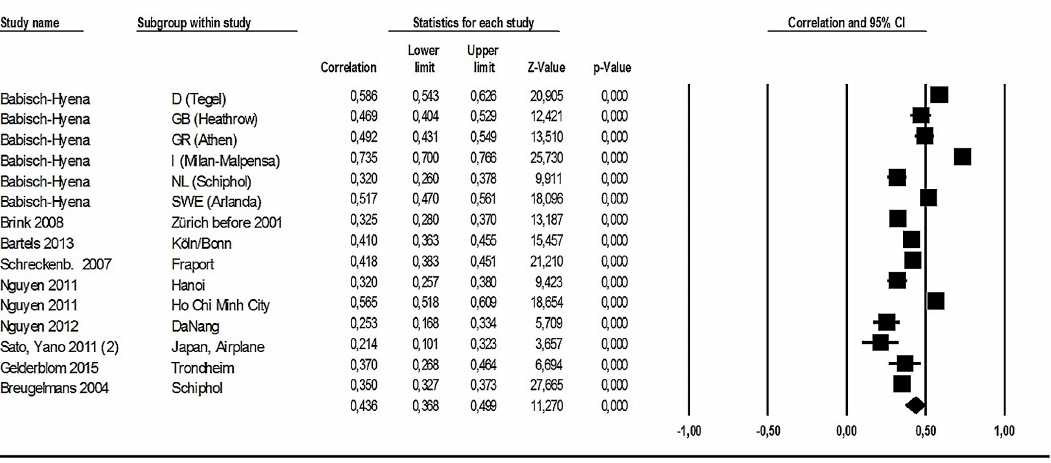
Figure 4. Meta ‐ analysis of 15 aircraft noise studies, based on correlations between individual L den or L dn and annoyance raw scores, Random Effects Model. The right part of the graph contains a forest plot of the correlations and their respective 95% confidence intervals. The figures of the last row indicate the summary estimates.